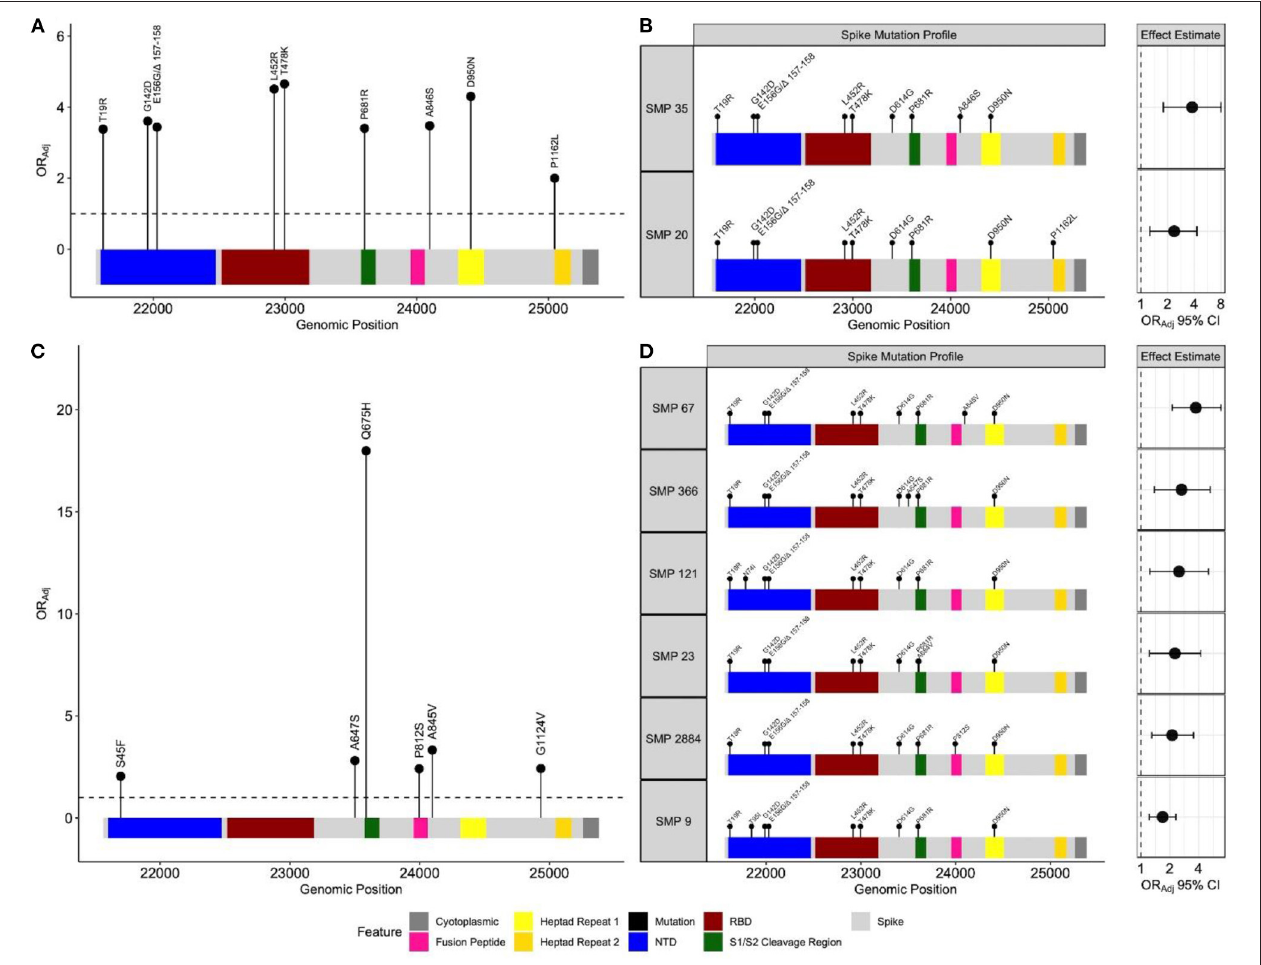
FIGURE 3 | Spike mutation variants and profiles associated with breakthrough infections during the emergence and predominance of the Delta-variant. Separate elastic net models were fit to identify either individual spike variants, or spike mutation profiles (SMP) associated with breakthrough infections. (A) Depicts individual mutations associated with breakthrough during the emergence ( n = 19,624) and (C) predominance of the Delta-variant ( n = 17,331). The black circles represent the odds ratio for each mutation, adjusting for age, sex, health authority, and month of collection. The profiles for each SMP identified during the (B) emergence ( n = 14,606) and (D) predominance periods ( n = 14,799) are plotted with their corresponding odds ratio and 95% confidence intervals, adjusting for age, sex, health authority, and month of collection. The reference group SMP consisted of the most common Delta spike variants (T19R, G142D, E156G 1 157–158, L452R, T478K, D614G, P681R and D950N). The N-terminal domain and receptor binding domain are abbreviated with NTD and RBD,